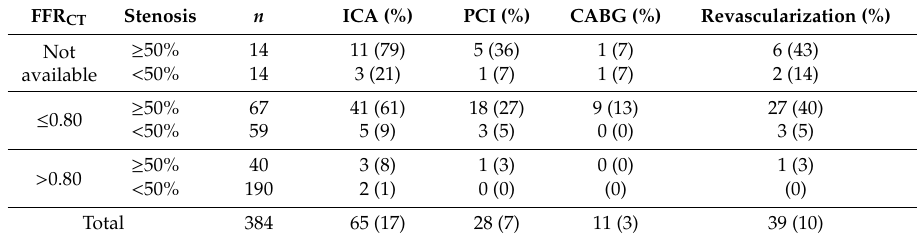
Table 3. Outcome of ICA and revascularization based on CT stenosis and FFR